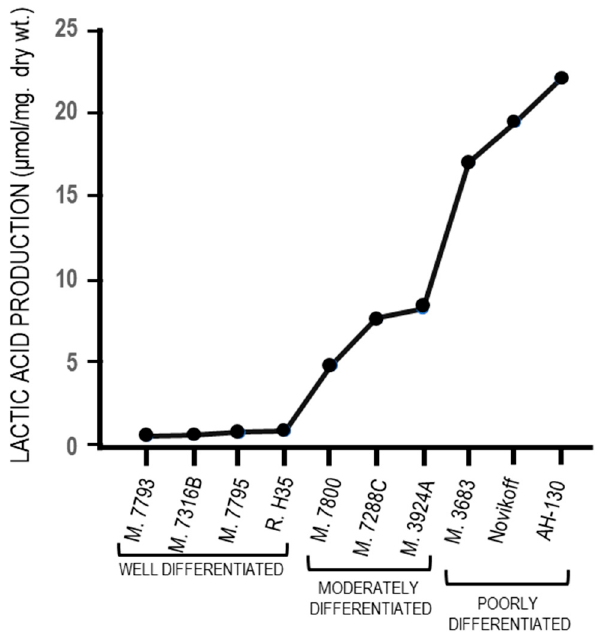
Figure 9. Aerobic glycolysis in hepatocellular carcinomas with different levels of differentiation.